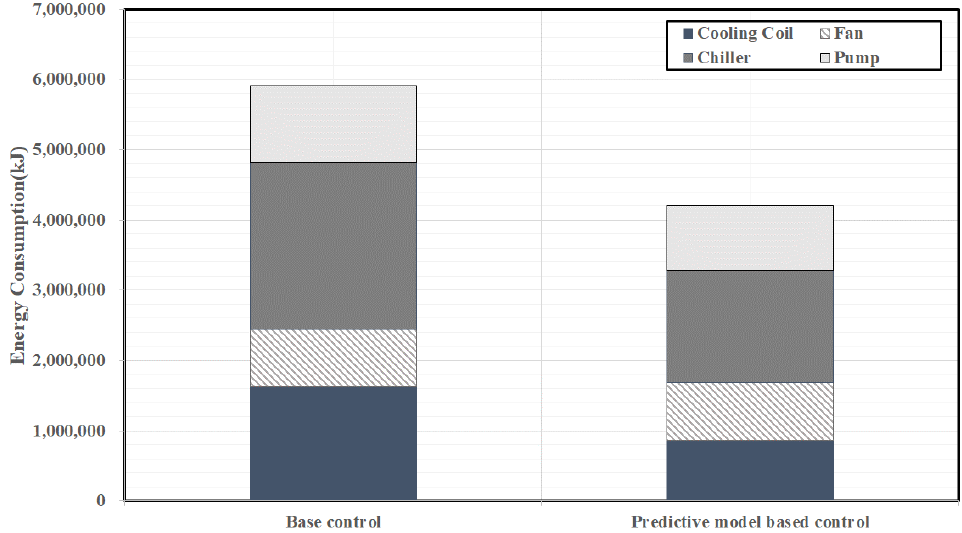
Figure 8. Total energy consumption.